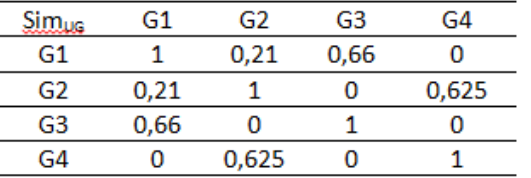
Table 5. Similarity, Simug, between graphs